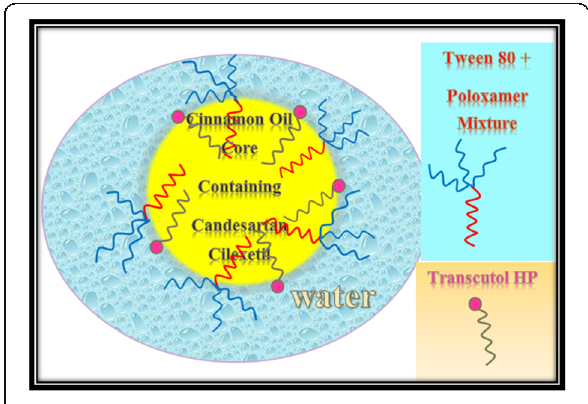
Fig. 5 Schematic representation of candesartan cilexetil nanoemulsion droplet